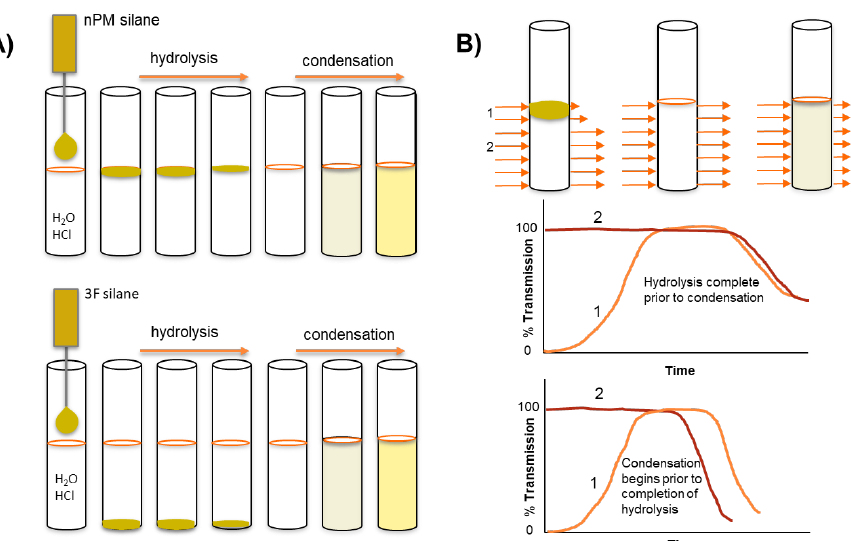
Figure 2. ( A ) Schematic of n-propyltrimethoxy silane (nPM) and 3,3,3-trifluoropropyl trimethoxy silane (3F) silane sol-gel reaction in aqueous solution catalyzed by weak acid. ( B ) Turbiscan height profile of reaction tube monitors the depletion of neat silane through hydrolysis and subsequent particle formation (sol) through condensation-induced turbidity. Reaction conditions can be tuned to favor completion of hydrolysis prior to the onset of condensation. Continuous scanning of the reaction tube provides transmission changes at defined height and time intervals.